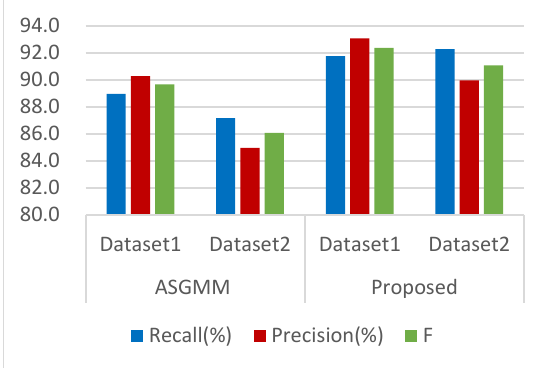
Figure 7. Change detection accuracy for each